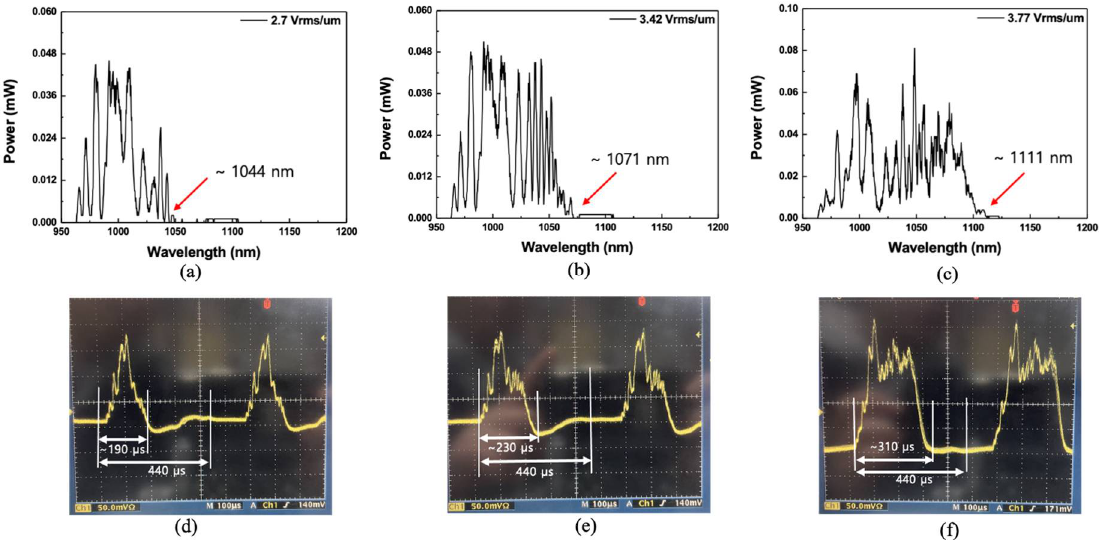
Figure 7. Optical spectra of the first-order reflection band from the CLC cell when the electric field was ( a ) 2.70, ( b ) 3.42, and ( c ) 3.77 V rms /µm, and ( d – f ) the oscilloscope displays of the first-order reflection band corresponding to the applied electric fields in ( a – c ), respectively [Supplementary Videos S1 and S2].